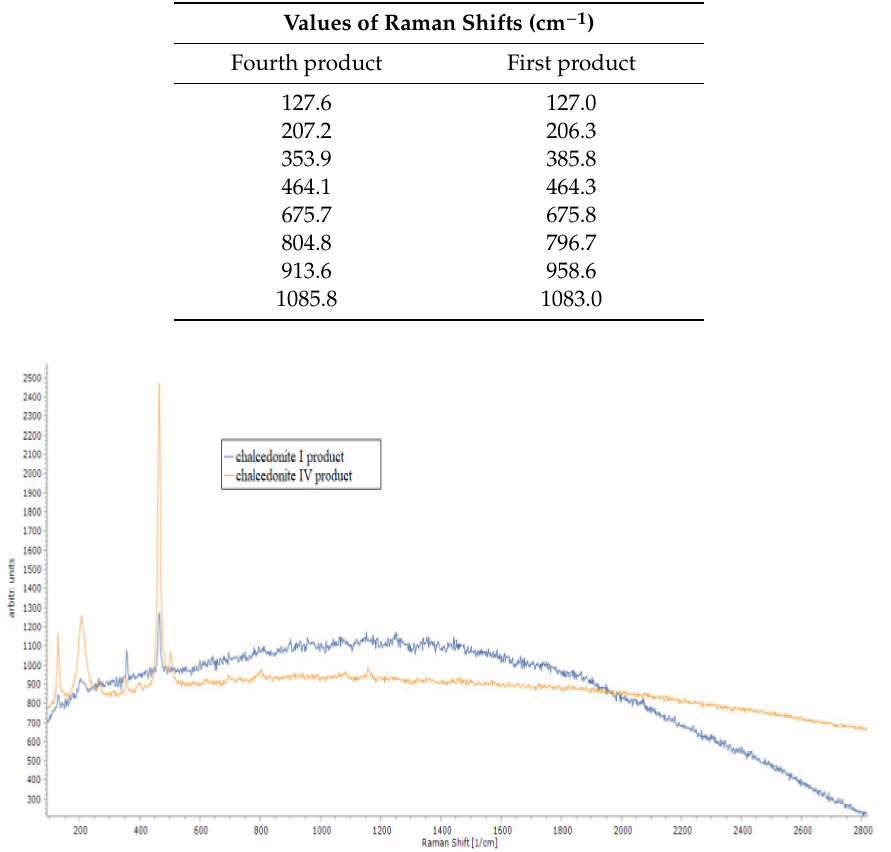
Figure 9. The Raman spectrum obtained during irradiation of the chalcedonite samples from the first and fourth jig